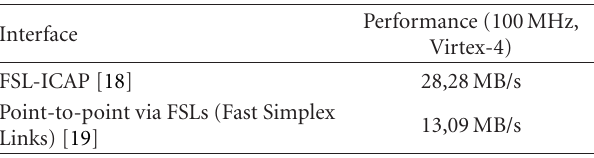
Table 3: Performance of the currently supported di ff erent inter- faces in RAMPSoC.